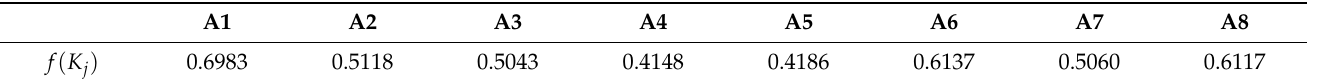
Table 10. Regulatory risk utility function of market-oriented business based on the BWM-MARCOS model.